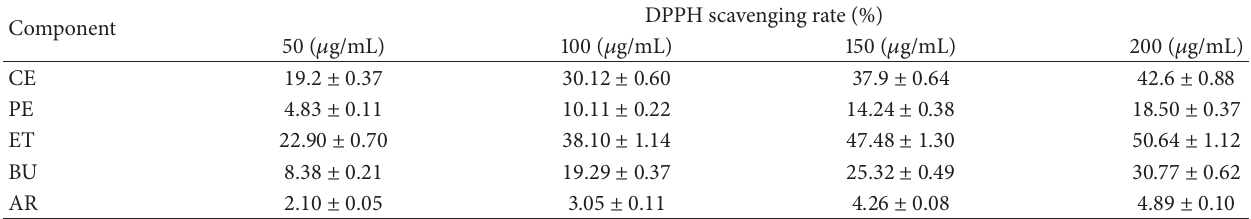
Table 1: DPPH scavenging activity of different components isolated from S. clava .